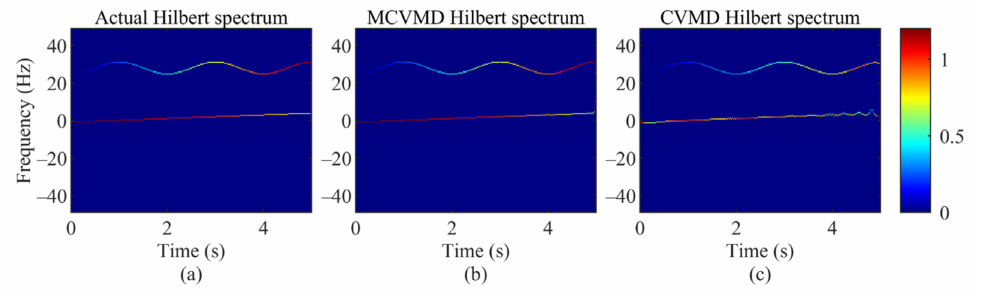
Figure 6. The Hilbert spectrum: ( a ) the actual Hilbert spectrum, ( b ) the MCVMD Hilbert spectrum, and ( c ) the CVMD Hilbert spectrum.